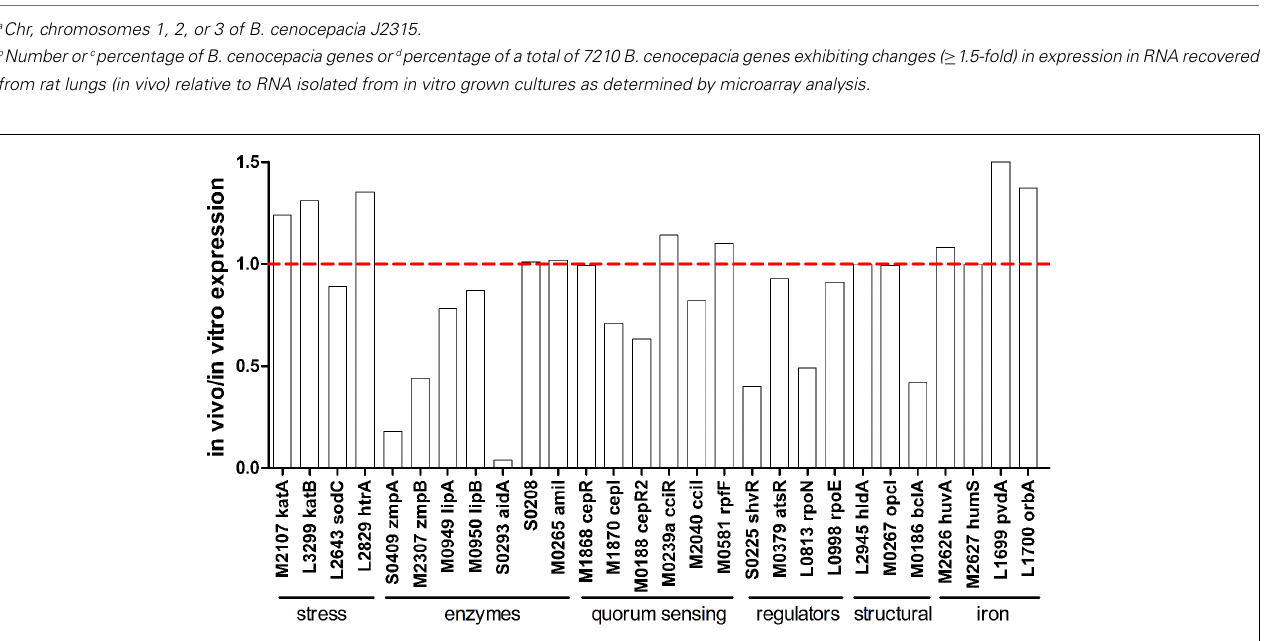
FIGURE 1 | In vivo expression of characterized virulence genes. Expression ratio of RNA recovered from rat lungs ( in vivo ) relative to RNA isolated from in vitro grown cultures as determined by microarray analysis.The “BCA” designation has been removed from names of genes encoded on chromosomes 1, 2, and 3 for image